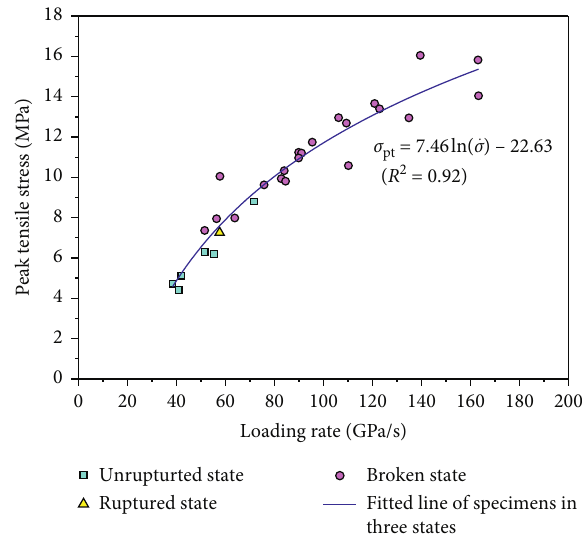
Figure 5: Relationship between loading rate and peak tensile stress of red sandstone